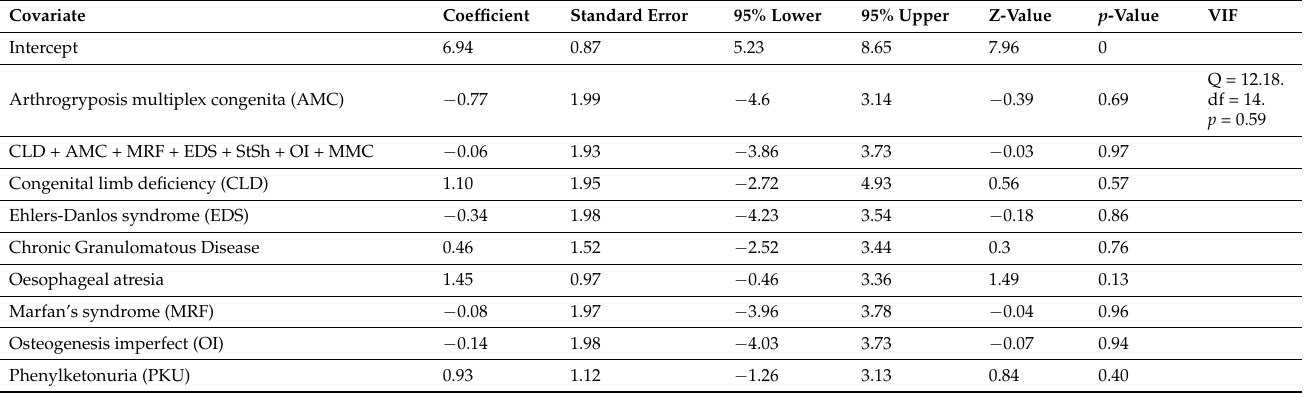
Table 5. Meta-regression by type of rare